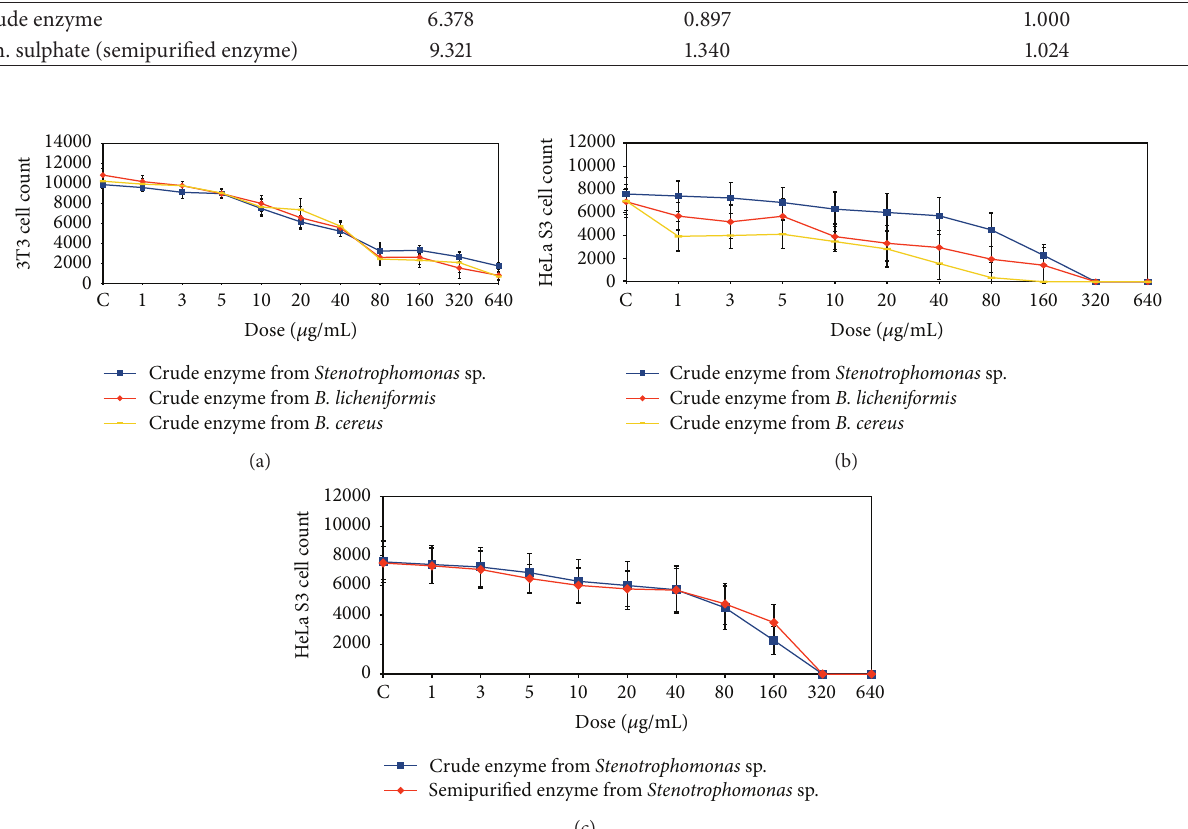
Figure 1: Cells count after treatments with enzyme from the three isolates. All experiments used MTT assay as mentioned in the method. 3T3 cell counts after treatment with crude enzyme (a); HeLa S3 cell counts after treatment with crude enzyme; (b) HeLa S3 cell counts after treatment with crude and semipurified enzyme from Stenotrophomonas sp.